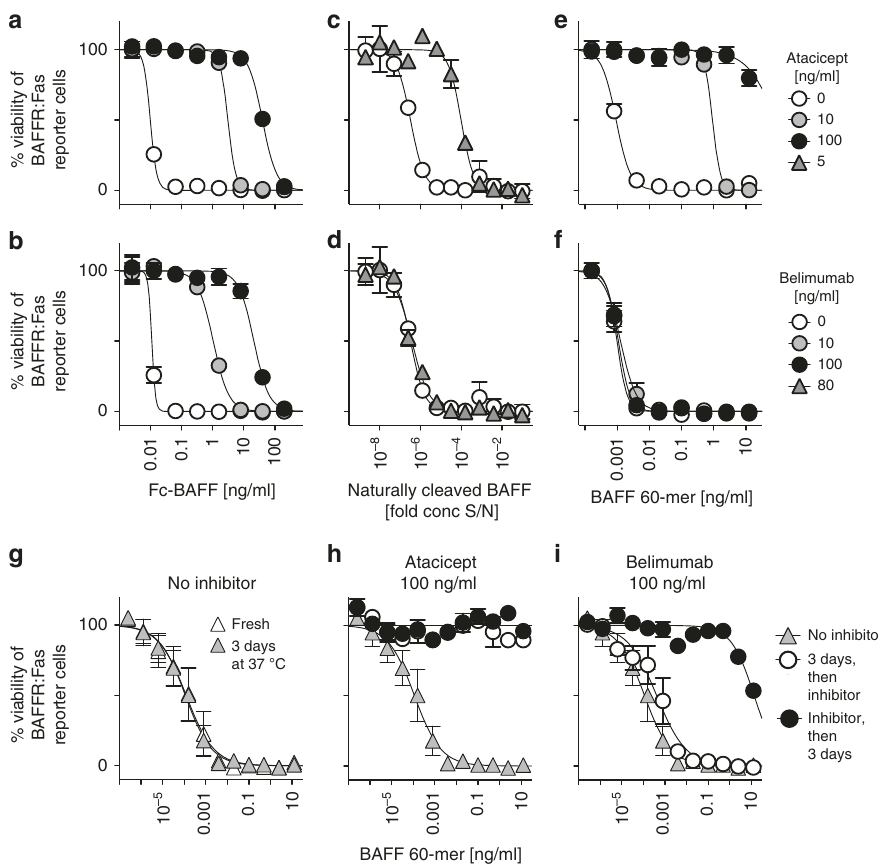
Fig. 6 Belimumab differs from atacicept in that it does not inhibit BAFF 60-mer promptly. BAFF-responsive BAFFR:Fas reporter cells were treated overnight with titrated amounts of the indicated forms of BAFF, in the presence or absence of the inhibitors atacicept or belimumab at fi xed concentrations. Cell viability was then monitored. a , b Inhibition of Fc-BAFF by atacicept ( a ) or belimumab ( b ). The experiment was performed 3 times. c , d Naturally processed hBAFF in supernatants of transfected 293 T cells exposed to atacicept at 0 or 5 ng/ml ( c ) or belimumab at 80 ng/ml ( d ). The experiment was performed twice. e , f Inhibition of Fc-BAFF by atacicept ( e ) or belimumab ( f ). The experiment was performed 3 times. g BAFF 60-mer was titrated in medium, then incubated in medium for 3 days at 37 °C, then added to reporter cells. Alternatively, BAFF 60-mer was titrated in medium just before the assay (fresh). h , i BAFF 60-mer was titrated in medium without or with atacicept ( h ) or belimumab ( i ) for 3 days at 37 °C. Samples without inhibitors received inhibitor or not after 3 days of incubation. Samples were then added to reporter cells. The experiment was performed twice. Panels a , b , e , and f show the mean ± SEM of 5 replicates, panels c and d of duplicate, and panels g , h and i of triplicate measures. The condition without inhibitor is the same in panels a and b , in panels c and d , in panels e and f , and in panels g , h , and i . See also Supplementary Fig.